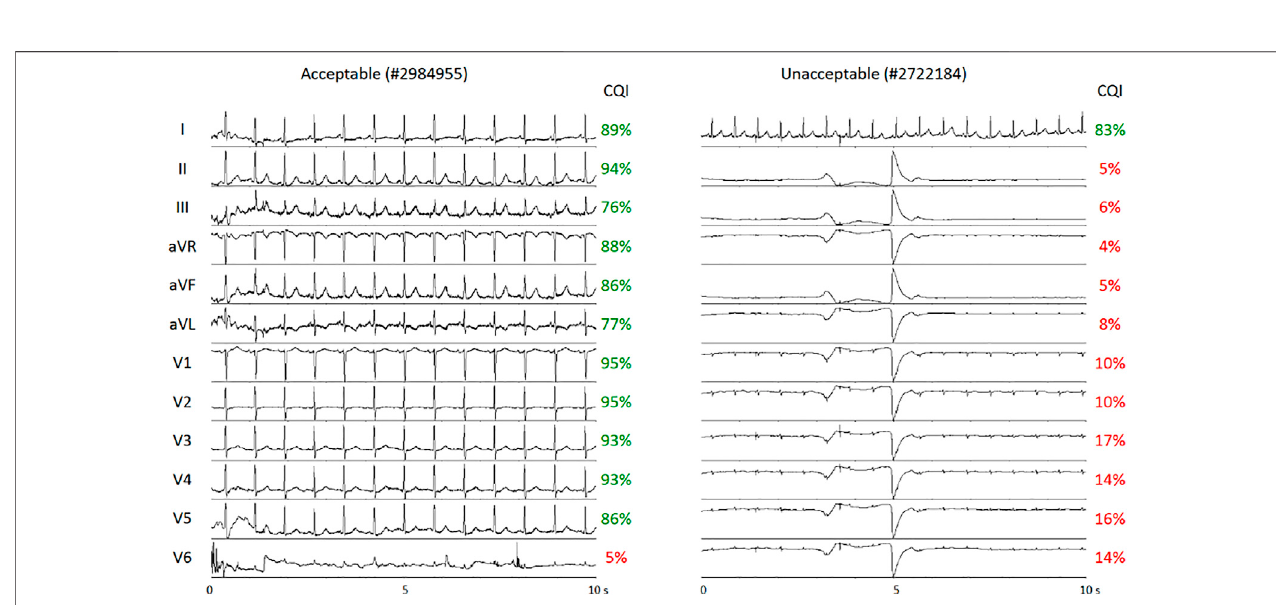
FIGURE5 | Examplesofmulti-lead ECGs from the dataset of Physionet/Computing in Cardiology 2011Challenge. The recordings wereclassi fi ed as “ acceptable ” (left) or “ unacceptable ” (right). CQI scores of individual leads correctly detect Lead I of suf fi cient quality for heart rate variability analysis in the “ unacceptable ” recording and Lead V6 as inadequate for heart rate variability analysis in the “ acceptable ”